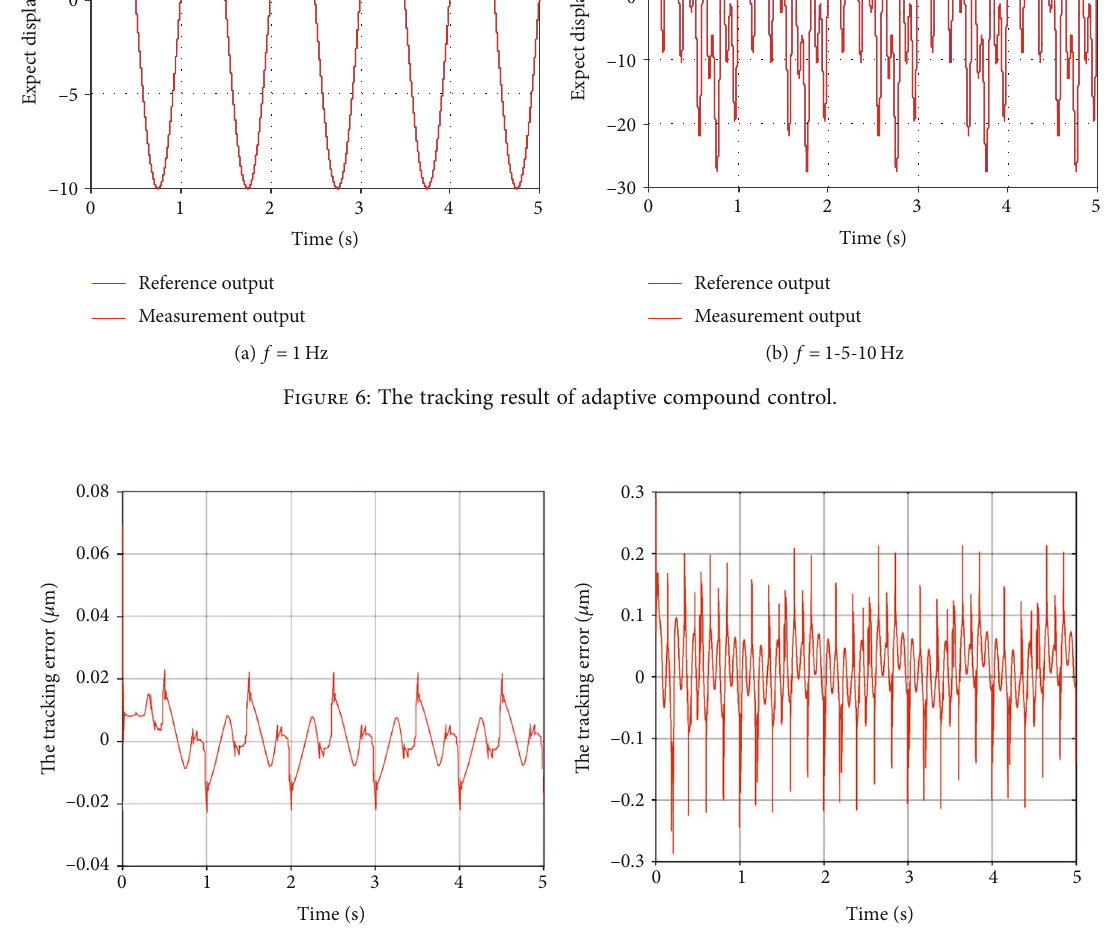
Figure 7: The tracking e ff ect curve of adaptive compound